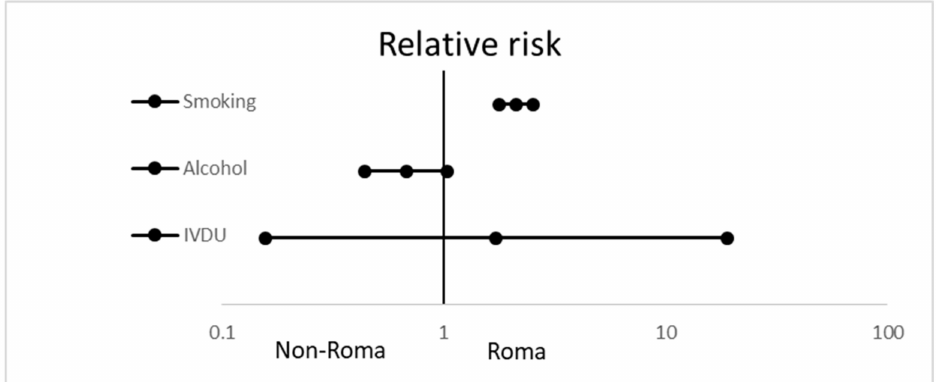
Figure 1. Relative risk with 95% confidence intervals of smoking, significant alcohol consumption, and intravenous drug use in Roma participants, compared with the non-Roma